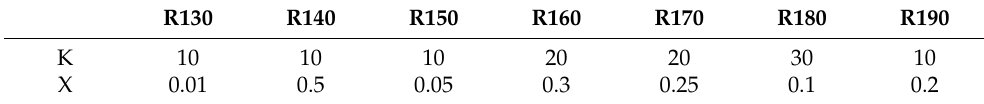
Table 2. Parameter optimization results of regular channel confluence